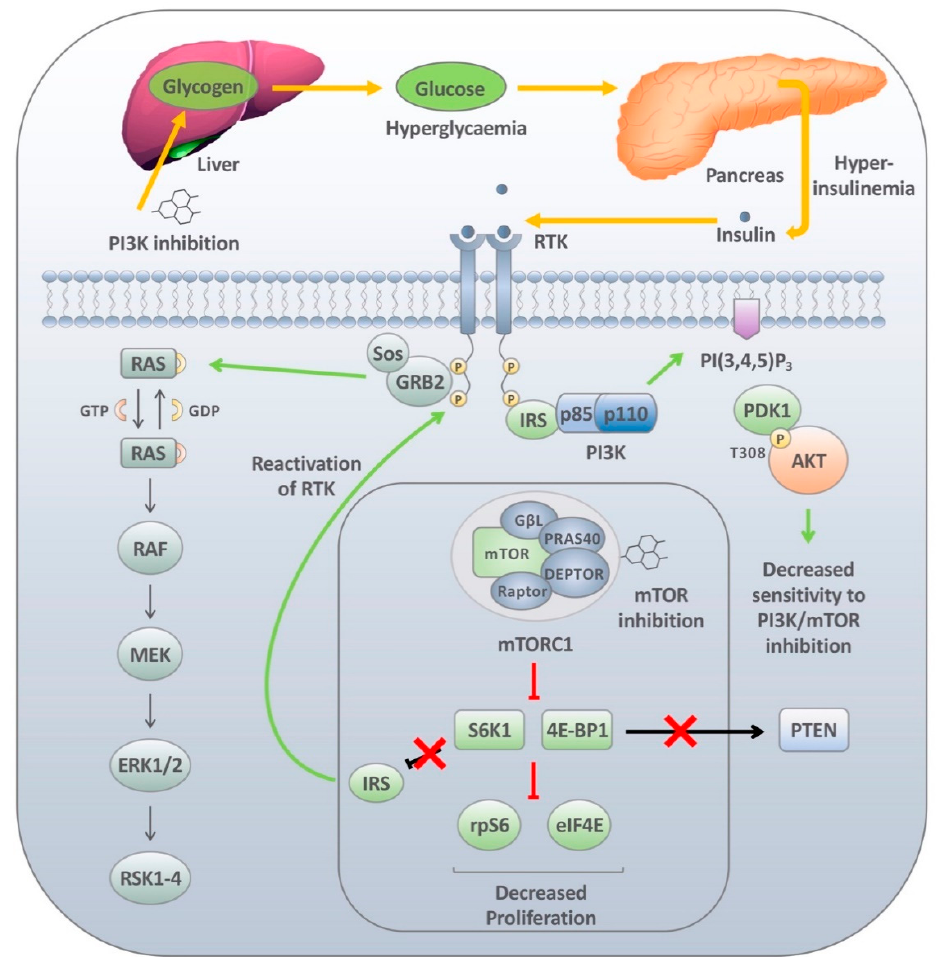
Figure 2. Insulin-mediated feedback loops following PI3K/mTOR inhibition. Following treatment with PI3K inhibitors, the liver breaks down stored glycogen releasing glucose into the bloodstream. The increased levels of glucose (hyperglycaemia) are detected by the pancreas, and in an effort to overcome these high levels of glucose, large amounts of insulin are released (hyperinsulinemia). This substantial release of insulin is sufficient to partially reactivate the insulin receptor which re-instates both IRS and GBR2 activity. What results is an increase in both PI3K and MAPK pathway activation, limiting the therapeutic effects of PI3K inhibitors. mTOR1 inhibitors, such as rapamycin, block downstream translation by downregulating S6K1 and 4E-BP1. In turn, this de-represses the S6K1 substrate IRS1, which acts as an intermediary between insulin receptor and the PI3K complex. The recruitment of PI3K to the active receptor enhances both MAPK and downstream PI3K signalling. Thus, limiting the overall sensitivity of mTOR inhibition in these tumours. Downregulation of mTOR activity either through AKT inhibition or direct mTOR inhibition blocks 4E-BP1-mediated translation of PTEN. This enhances the pool of PIP3 in cells resulting in the sustained activation of